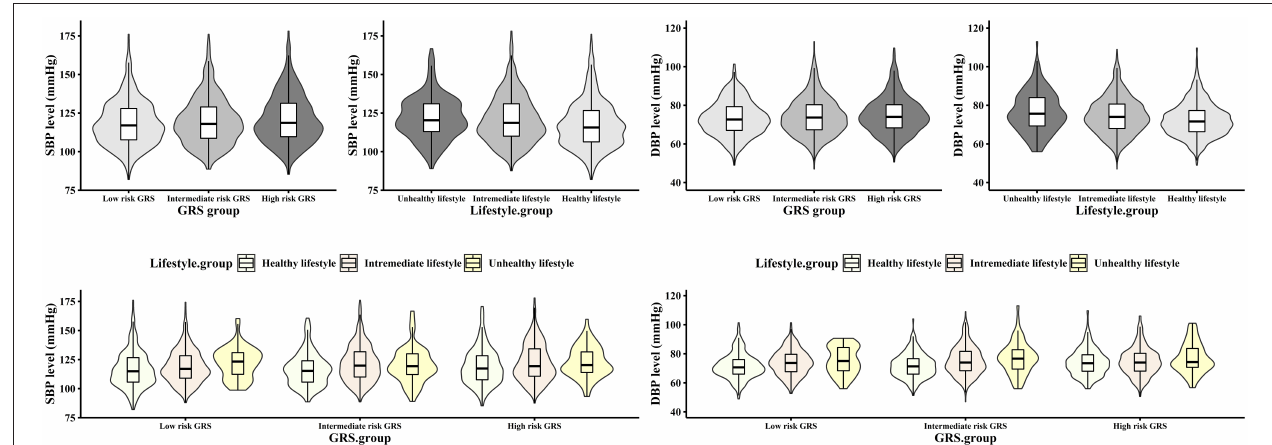
FIGURE 1 | Distribution of SBP and DBP levels in genetic and lifestyle risk groups. The box plot shows the location of the quantile and the external shape shows the density at any location. DBP, diastolic blood pressure; GRS, genetic risk score; SBP, systolic blood pressure.